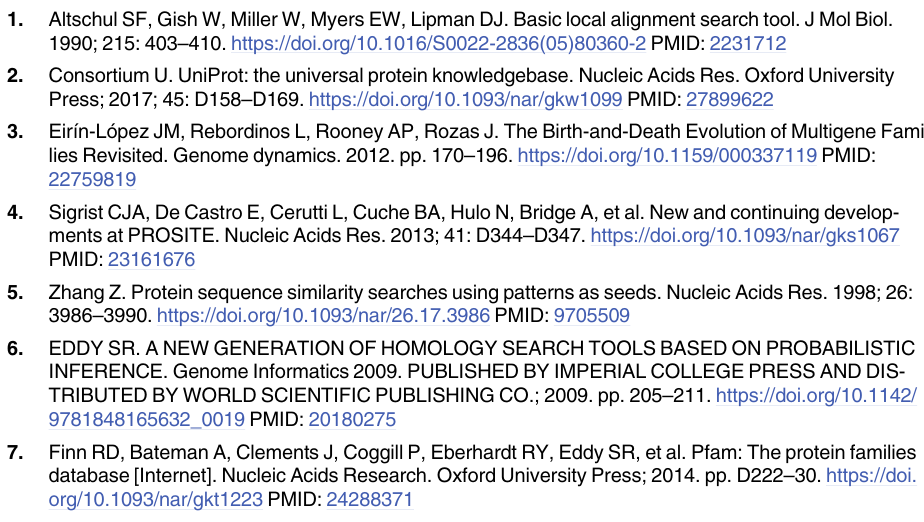
S7 Fig. Classification of ACD and PLC sequences using PANTHER. The top panels show the ACD family level and the sHSP subfamily level classifications. Each family is respresented by a different color. For the sHSP subfamily classification colors were chosen to represent sep- arate clusters. The lower panels show the classification of all PLC subfamilies containing a training sequence as well as two additional large subfamilies (PLC Top, random colors) and the classification upon combining subfamilies according to the functional classification according to SwissProt (For colors see Fig 4A). Data analysis is shown in Table